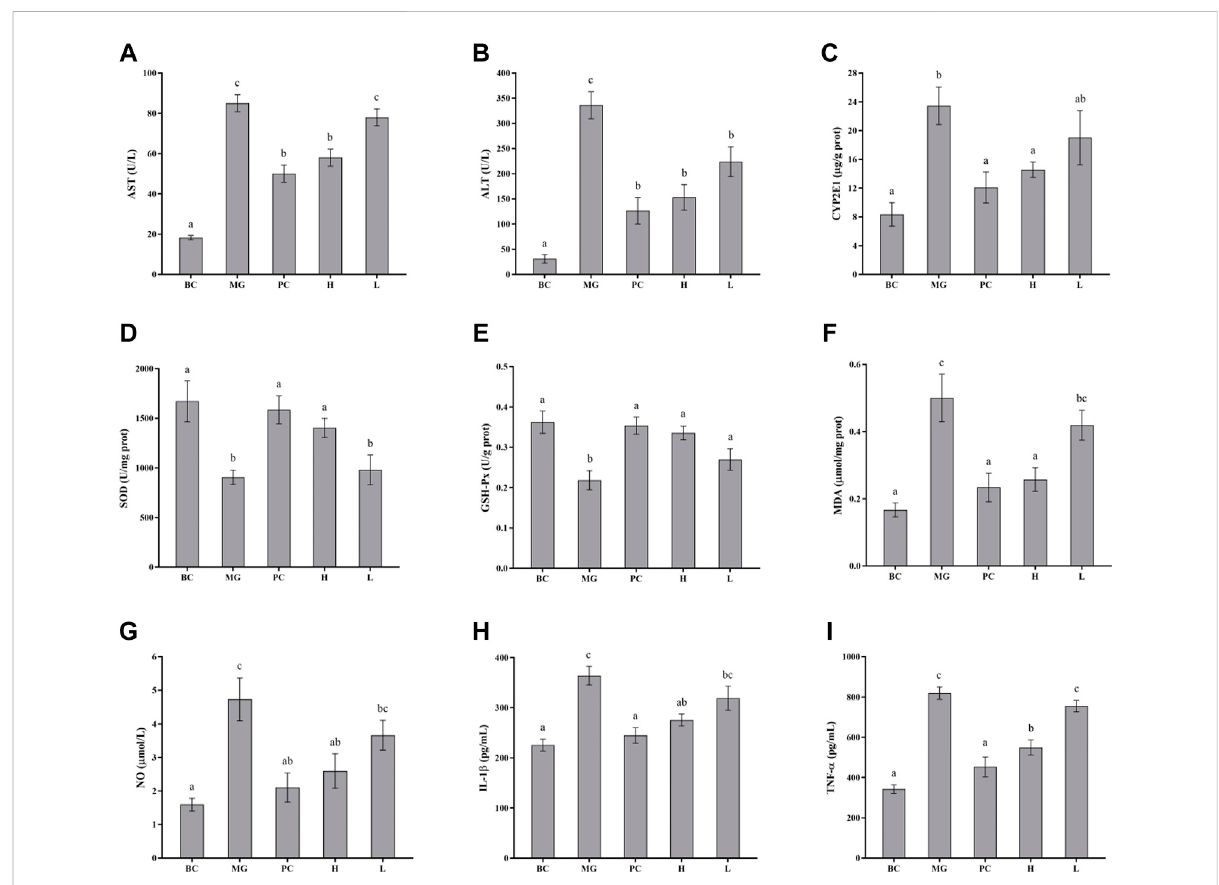
EffectofBRP-SeNPsonthecontentsof (A) AST,and (B) ALTinserumofmiceinducedbyCCl 4 . (C) RepresentsthecontentofCYP2E1intheliver. (D – I) Effect of BRP-SeNPs on indicators of liver oxidative stress and in fl ammatory mediators induced by CCl GSH-Px and MDA, and (G – I) represent the content of NO, IL-1 β and TNF- α in the liver, respectively. The different letters indicate signi fi cant differences ( p <